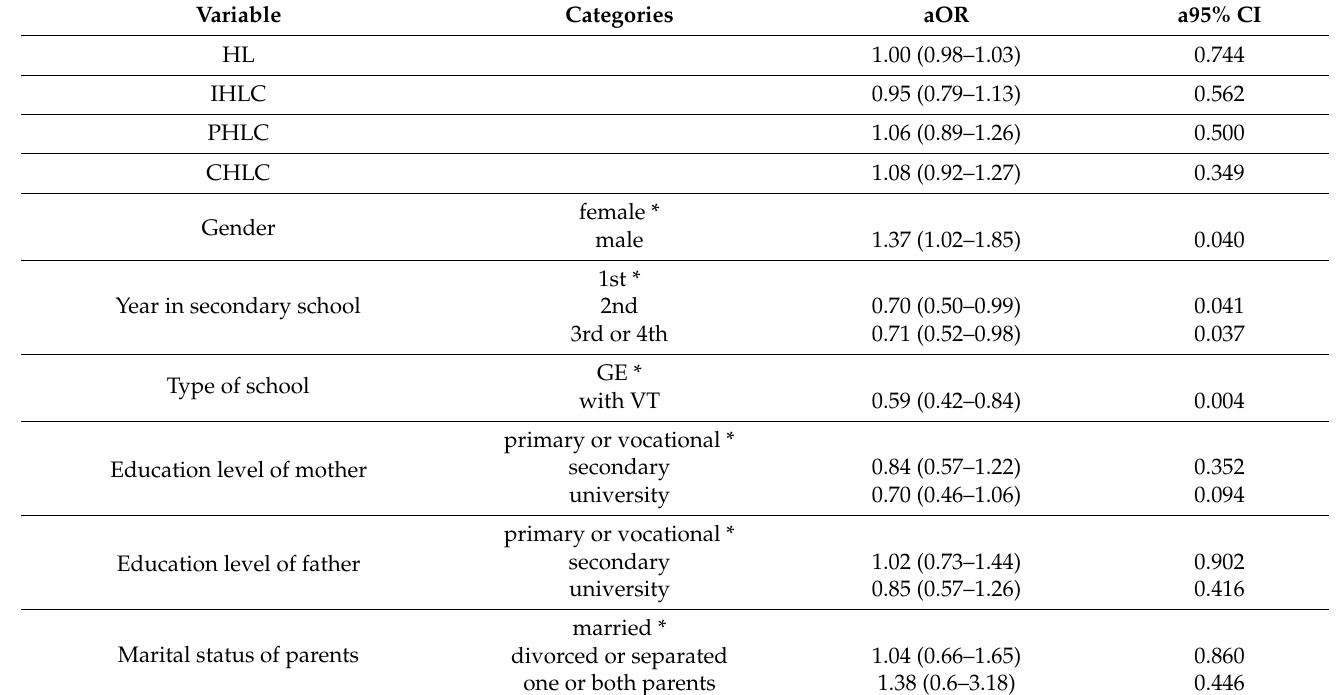
Table 3. Multivariate logistic regression model for the variable related to the most abundant